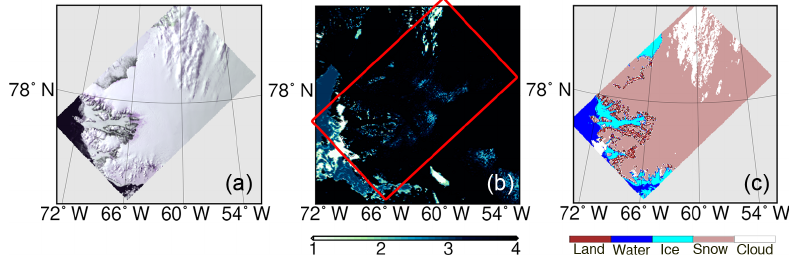
Figure 12. (a) RGB false-colour image (using 0.67, 0.87 and 0.55µm channels) of AATSR over Greenland, 18 May 2008, 23h 13min 38s, (b) MODIS cloud mask: 1 is cloudy, 2 is probably cloudy, 3 is probably clear, 4 is clear (red rectangle shows the coverage of AATSR) for 23h 5min, (c) cloud detection of